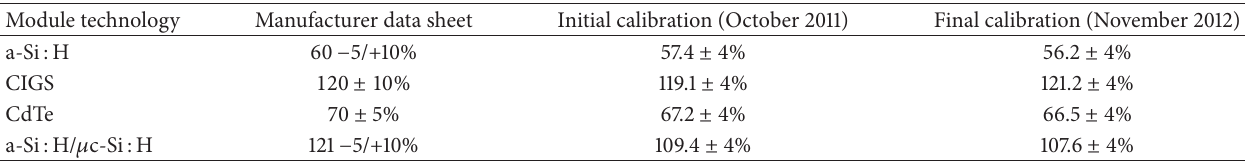
Table 1: Module maximum power in STC (W) of the four thin film PV modules under test as provided by the manufacturer and by both the initial and final outdoor calibration.